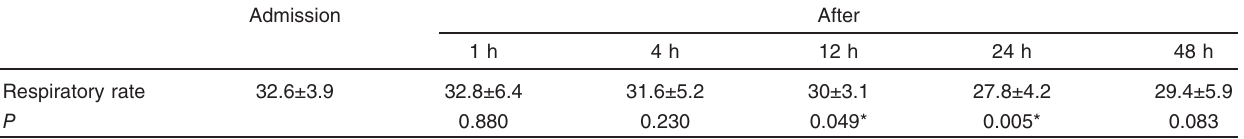
Table 9 Improvement of respiratory rate in successful cases of group I ( n = 5) at different studied periods